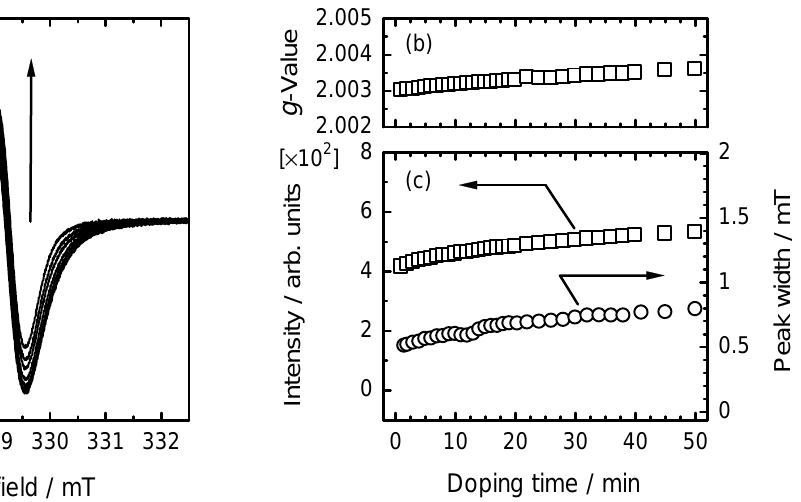
Figure 6. ( a ) ESR spectra of (–)-poly1 in bulk state with vapor phase iodine